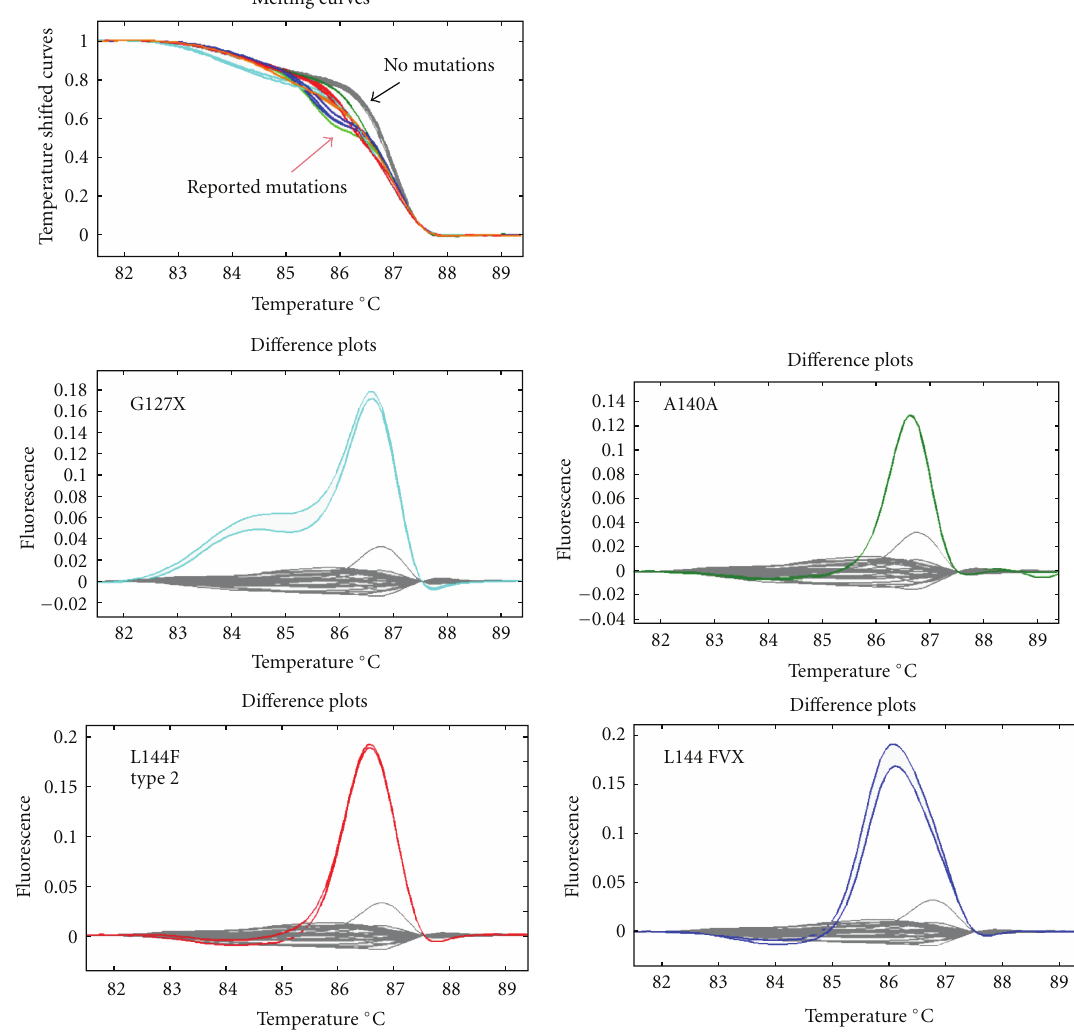
Figure 1: Melting curves and subtractive fluorescent di ff erence plots of a wild type (gray lines) and reported SOD1 mutations (colour lines). Di ff erence plots were easily identified for the